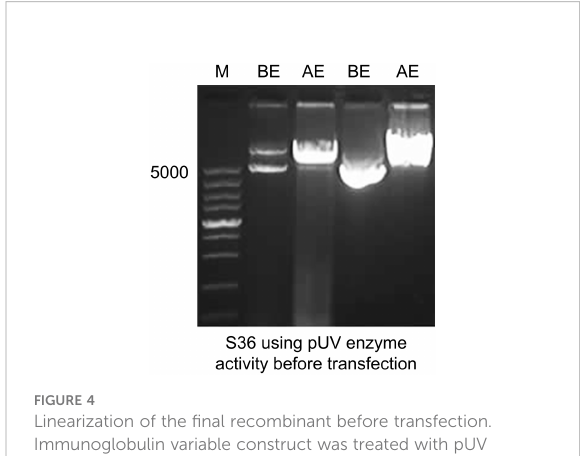
FIGURE 4 Linearization of the fi nal recombinant before transfection. Immunoglobulin variable construct was treated with pUV restriction enzyme and was loaded on 1% agarose gel. Before enzyme activity, the plasmid showed two band copies. After enzyme activity, a single band high localization was recorded. M represents 5000 base pairs molecular marker. The fi rst two lanes show heavy chain fragments before and after enzyme activity. The last two show before and after enzyme digestion for light chain